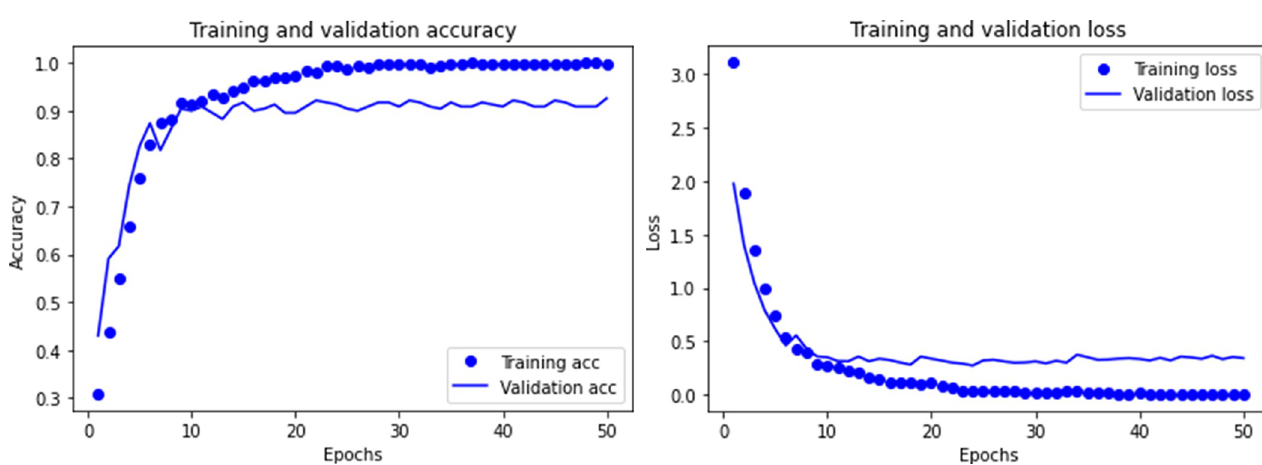
Fig 5. Accuracy and loss of CNN model when training 50 times.